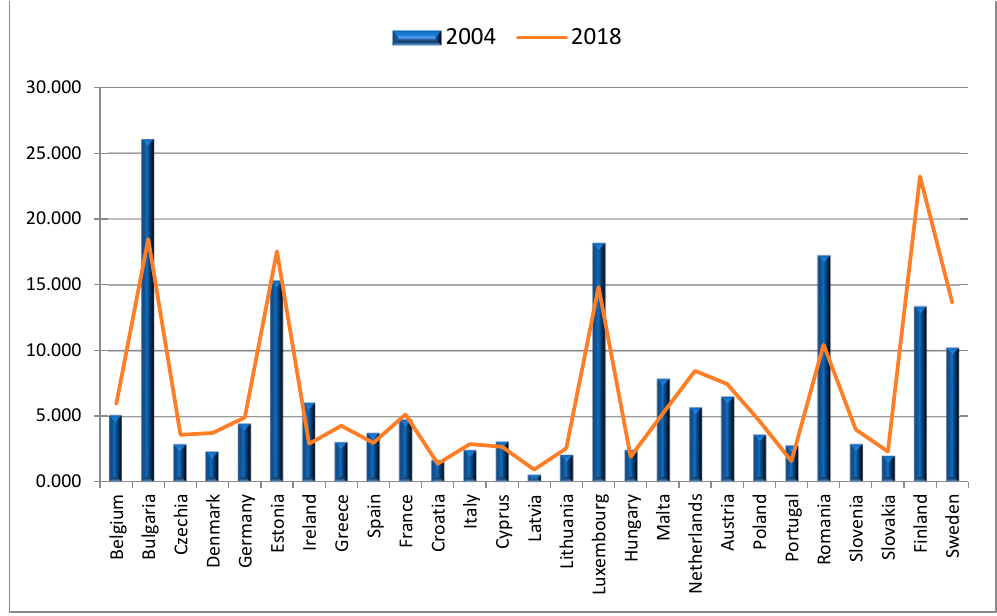
Figure 3. Waste generation in total industries and households (in kg per capita).